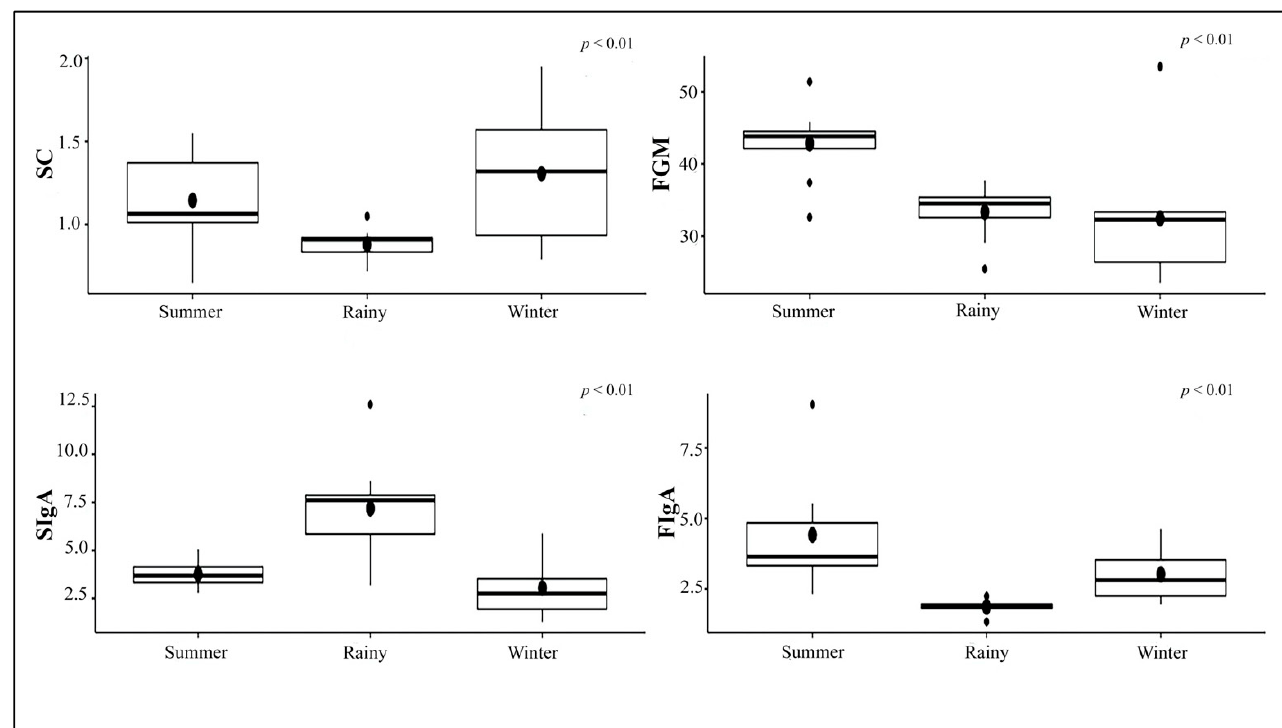
Figure 4. Boxplot presented concentrations of salivary cortisol (SC), fecal glucocorticoid metabolites (FGM), salivary IgA (SIgA), and fecal IgA (FIgA) categorized by season.